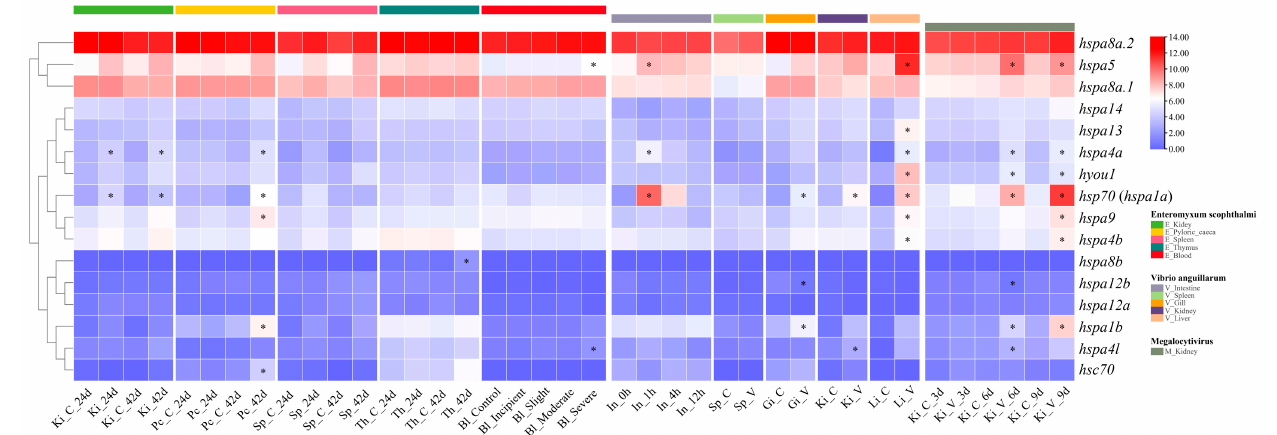
Figure 7. Heat map of HSP70 genes expression in S. maximus under pathogens ( E. scophthalmi, V. anguillarum, Megalocytivirus) infection. Ki, Pc, Sp, Th, Bl, In, Gi, and Li represent kidney, pyloric caeca, spleen, thymus, blood, intestine, gill, and liver, respectively. C represents control group, V represents V. anguillarum infection, M represents Megalocytivirus infection. Cells with different colors correspond to different expression levels, which were normalized into log 2 (TPM + 1). * indicates the differentially expressed (or significantly up- or downregulated) HSP70 genes with |log 2 FC| > 1 and FDR < 0.01.